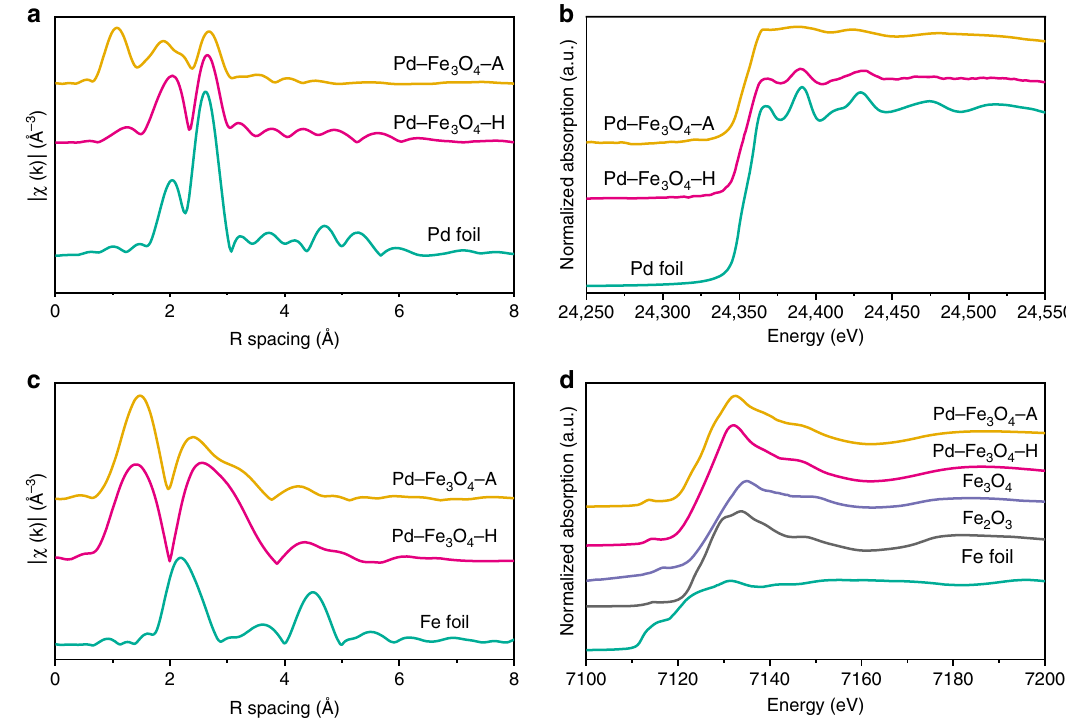
Fig. 3 XAFS characterization of prepared samples and reference samples. a Pd K-edge EXAFS; b Pd K-edge XANES; c Fe K-edge EXAFS; and d Fe K-edge XANES. Source data are provided as a Source data fi